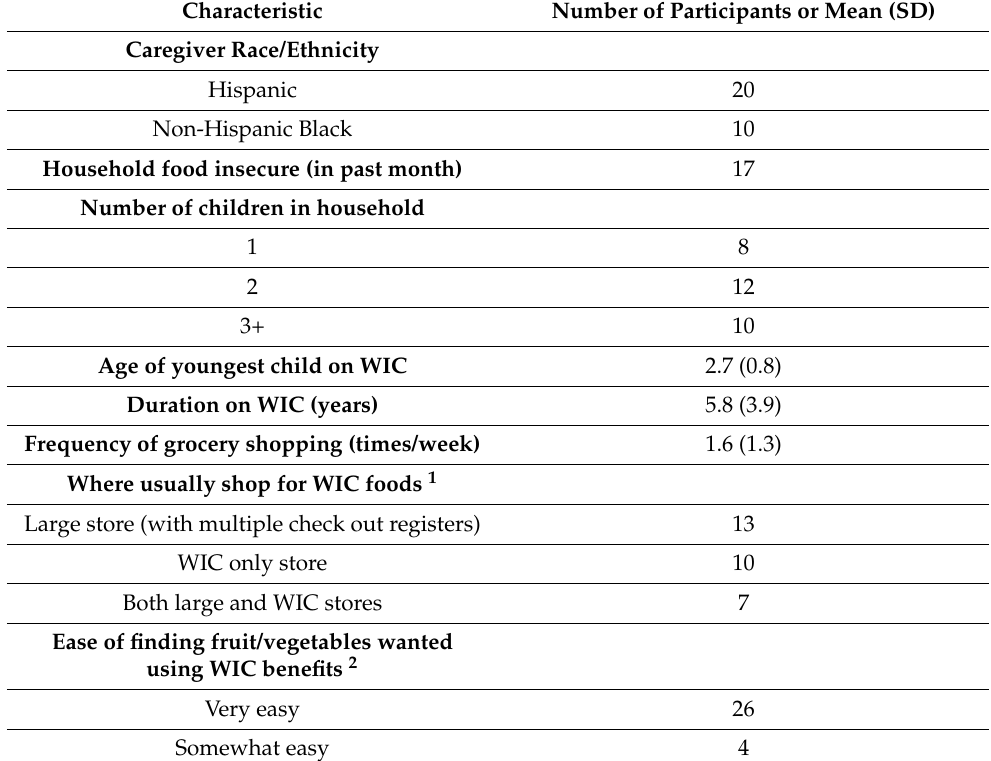
Table 1. Characteristics of caregivers interviewed (n = 30).